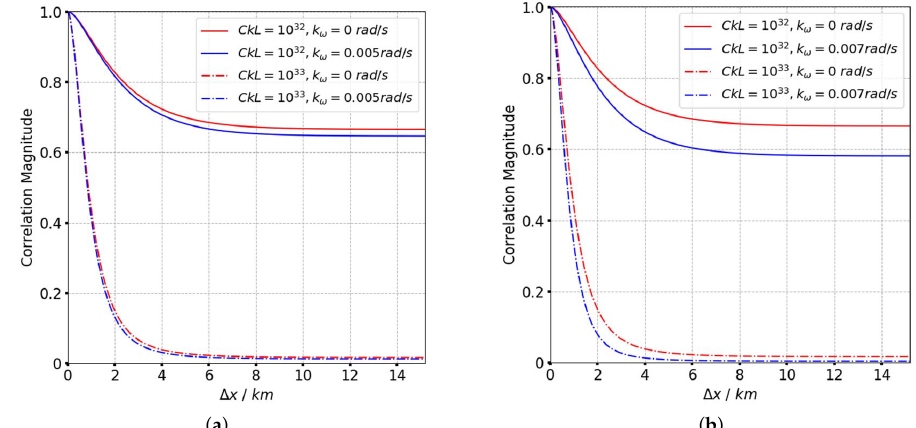
Figure 6. The comparison of TFTPCF curves between stripmap mode (red curves) and sliding spotlight mode (blue curves) with different C k L (real line: C k L = 10 32 , dashed line: C k L = 10 33 ).